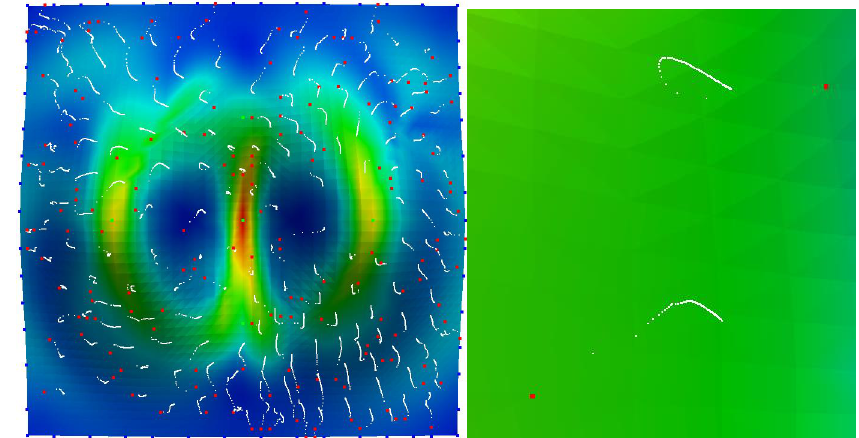
Figure 9. Trajectories of point convergences. The red points indicate the initial sample set, and the trajectories show the convergence trends, with closer gaps between candidate points. The right side shows a close view of the convergence of two points. These trends imply that the cCVT’s convergence complies with Lloyd’s relaxation linear convergence.